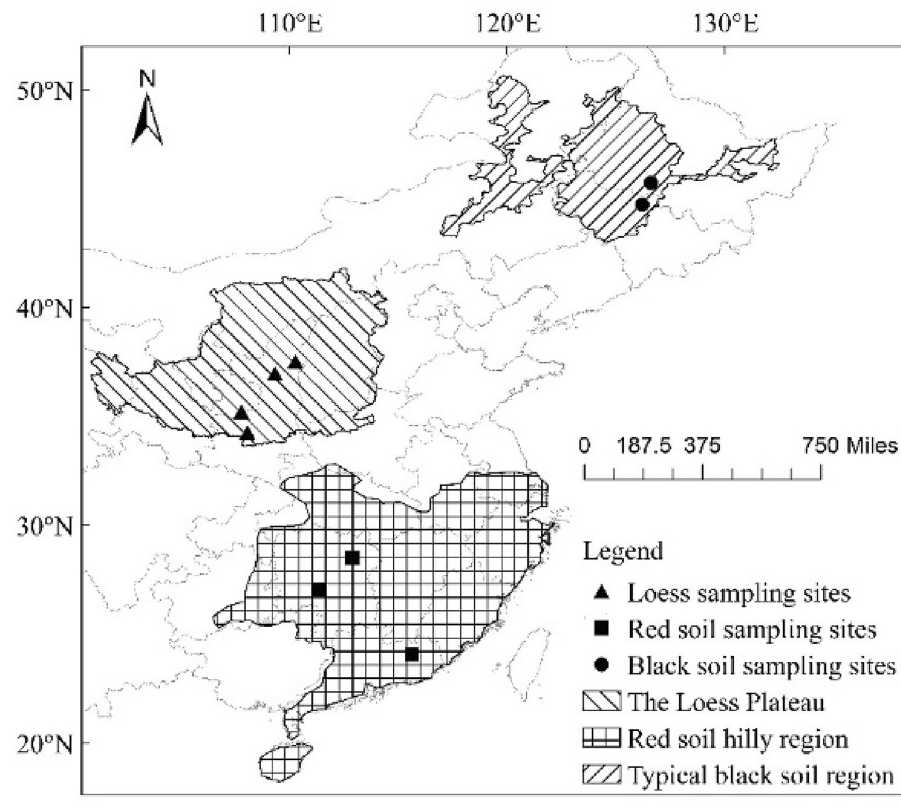
Table 1 Selected properties of the original soils of black soil, red soil and loess